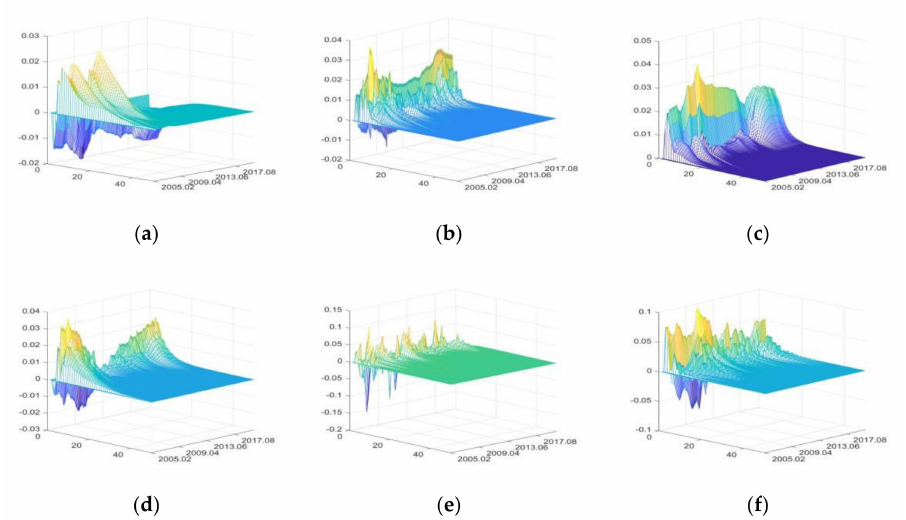
Figure 12. The three-dimensional impulse responses of FR to positive shocks of external uncertainties. ( a ) Shocks of IRU. ( b ) Shocks of FU. ( c ) Shocks of SDU. ( d ) Shocks of CU. ( e ) Shocks of DE. ( f ) Shocks of